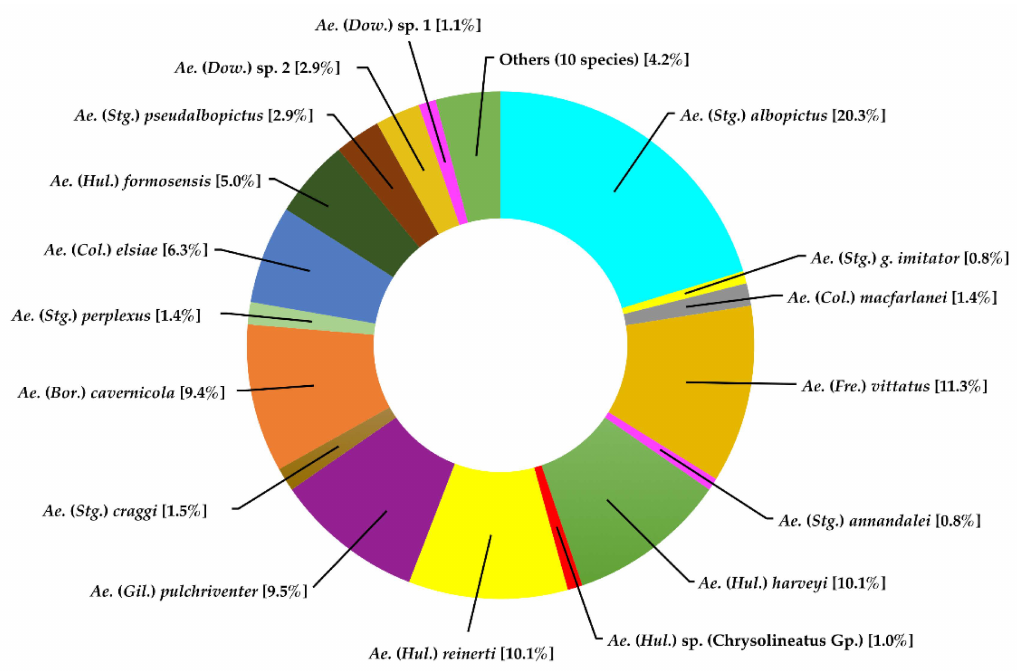
Figure 4. Species composition and abundance of mosquitoes of the genus Aedes collected in Doi Inthanon National Park.